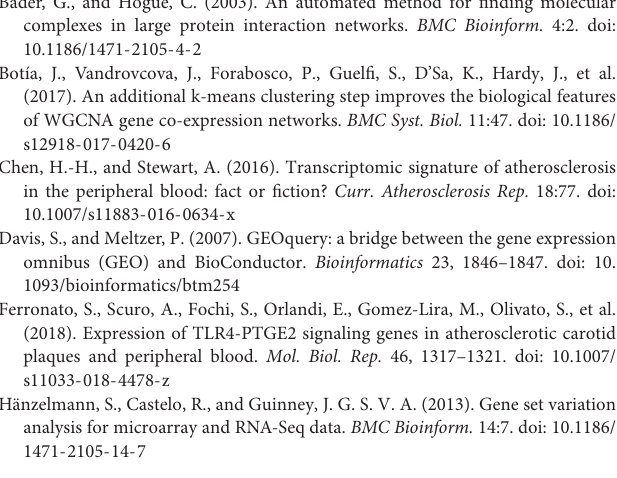
Supplementary Table 1 | The information (GPL version, samples) of the three